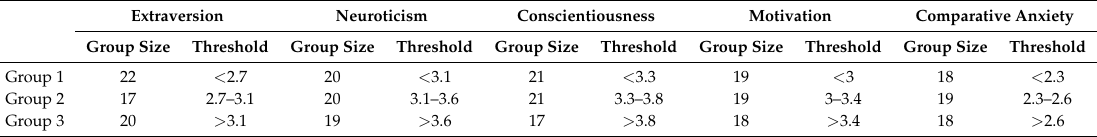
Table 5. Different group sizes and thresholds for each personality and dedication trait